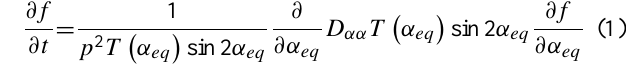
Fig. 7. Latitudinal distribution of the averaged electric field spectral intensity in the frequency range from 24 to 34kHz during the period from 1989 to 1995 (courtesy of Kobayashi, 1997).